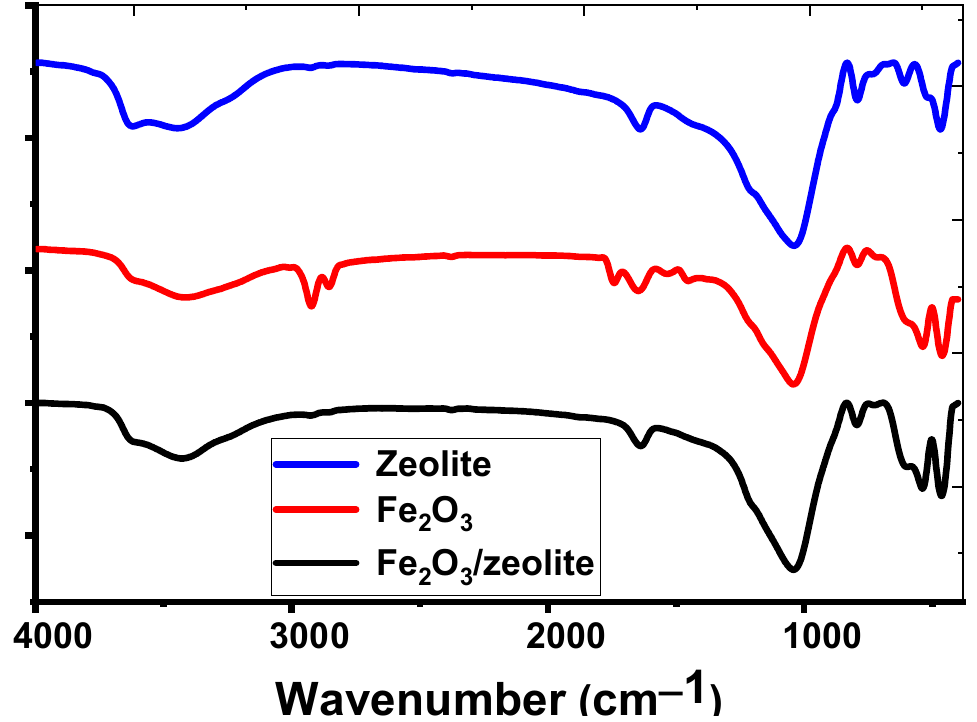
Figure 3. FTIR spectra of zeolite, Fe 2 O 3 , and Fe 2 O 3 ‐ zeolite